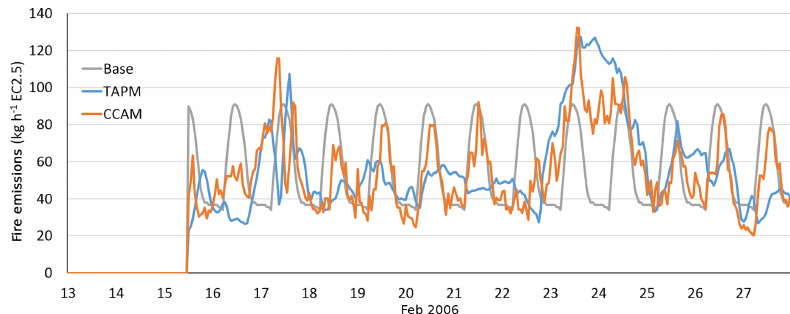
Figure 2. Base hourly diurnal emissions and emissions using the revised McArthur Forest Fire Danger Index (FFDI) generated using TAPM and CCAM meteorology.